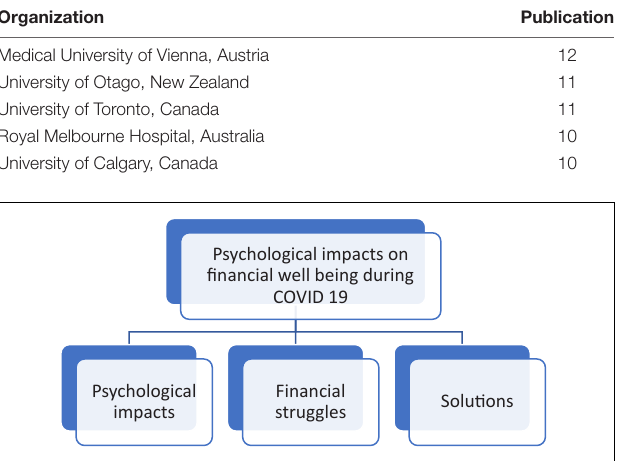
TABLE 2 | Leading research organizations.